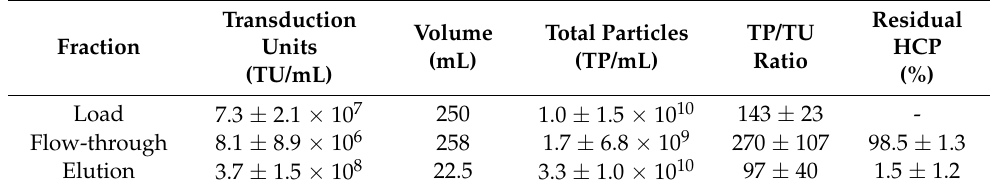
Figure 5. Evaluation of a novel Affinity chromatography for lentiviral vector purification. ( A ) Chromatogram of VSVG-LVs purification using Lenti VSVG Affinity Matrix at 1 mL scale and 2 min residence time (top) and Western blot signal profile for flow-through, elution, and strip fractions using anti-p24 antibody (bottom). Blue and yellow lines represent absorbance at 280 nm and 260 nm, respectively. ( B ) Purification performance of the VSVG affinity resin at a 1 mL scale. TU recovery yield (%) is represented for each replicate ( n = 3). Error bars are the standard deviation obtained from the titration method. Table 2. LVs quality assessment for the intermediate scale (10 mL resin) purification process using the novel Lenti VSVG Affinity Matrix. ( n =